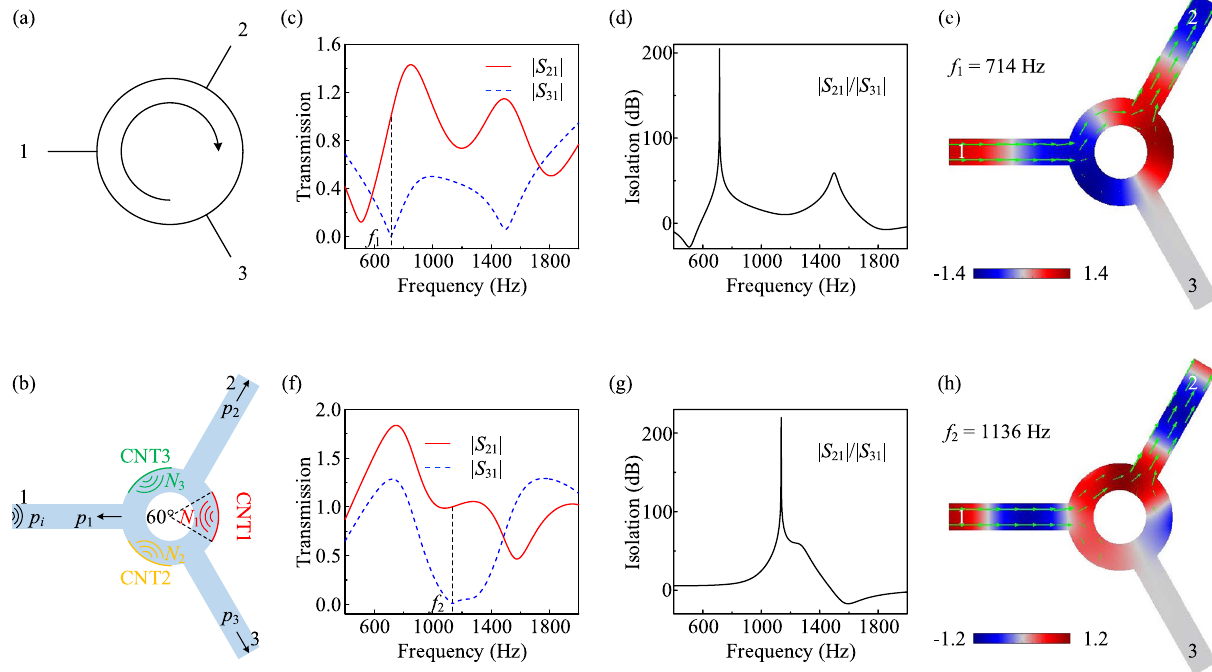
Figure 2. Compact acoustic isolator. ( a , b ) An isolator as an exception of a circulator, its schematic model ( a ) and its implementation by using three actively controlled CNT films stuck to the wall of the ring ( b ). Sound propagates from port 1 to 2, but not 3. ( c ) Case of optimal biasing control (Case I) for maximum nonreciprocity, with total transmission to port 2 and zero transmission to port 3 at f 1 = 714 Hz. ( d ) Isolation in decibels with | S 21 | / | S 31 | . ( e ) Acoustic pressure field distribution inside the optimally biased device. ( f – h ) Same as ( c – e ), but with the CNT film parameters of Case II at f 2 = 1136 Hz. Green arrows represent the average acoustic power flow in ( e ) and ( h